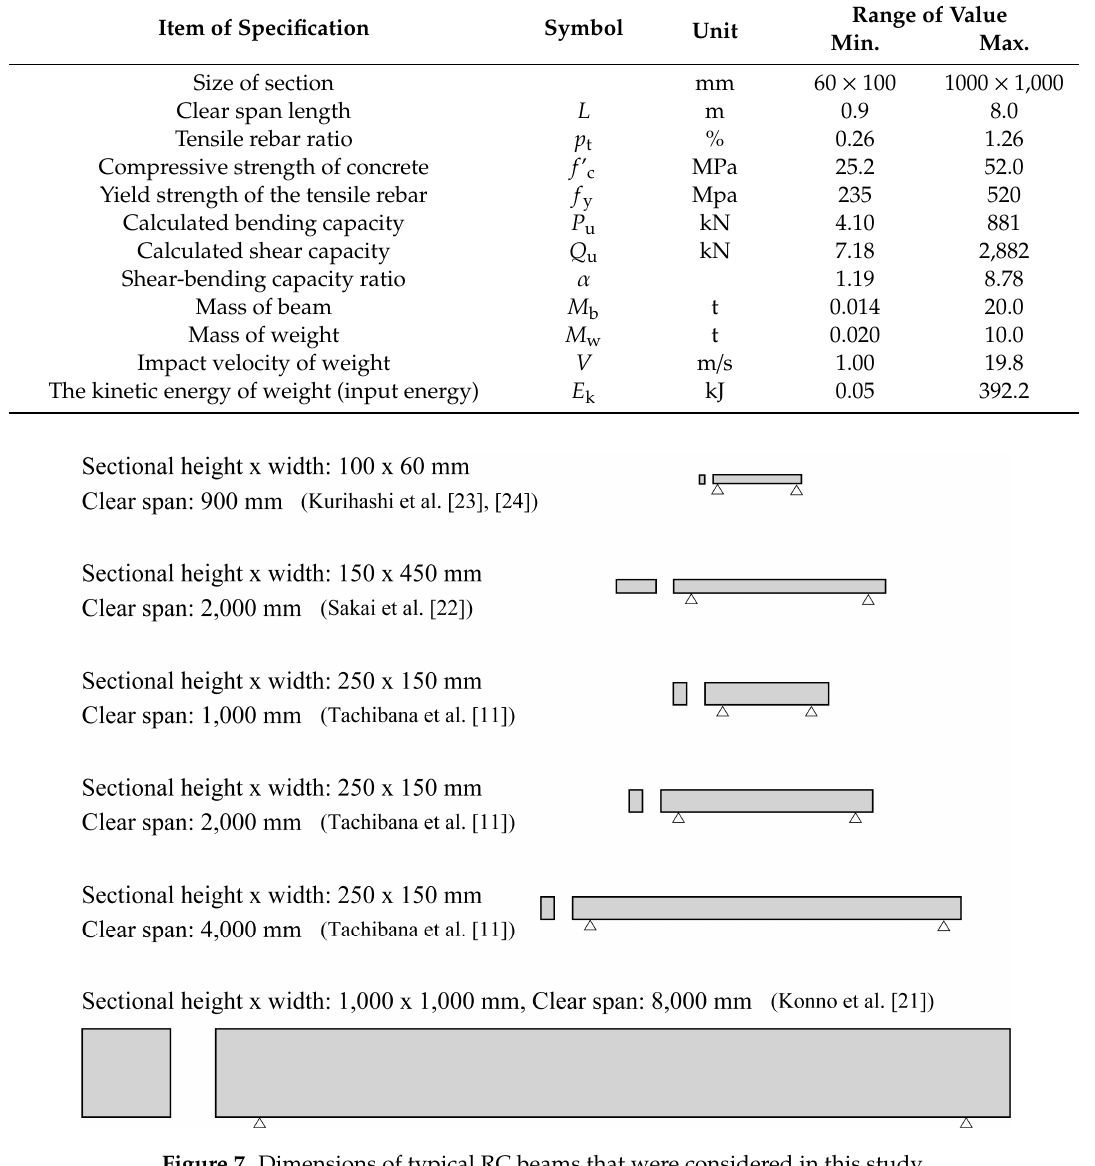
Figure 7. Dimensions of typical RC beams that were considered in this study.